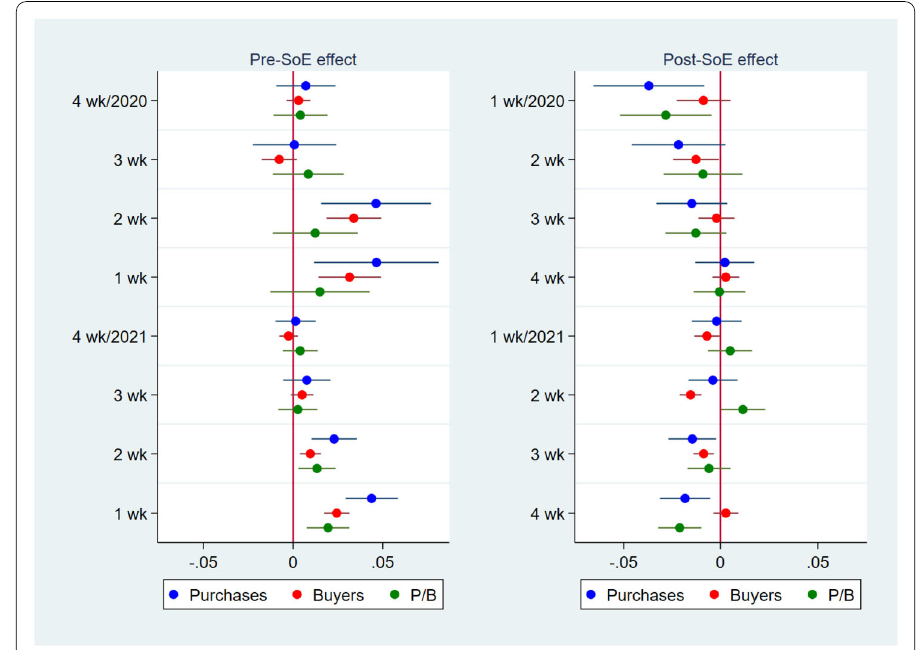
Figure 6 Pre- and Posttreatment Effects of the Declaration of a State of Emergency on the Purchase Amount, the Number of Buyers, and the Purchase Amount per Buyer. This figure illustrates the results from the regressions of the purchase amount, the number of buyers, and the purchase amount per buyer in logs at the city–date level. The left panel shows the point estimates and 95% confidence intervals of the dummies for 1-4 weeks before the declaration of a state of emergency (SoE) on the purchase amount (blue), the number of buyers (red), and the purchase amount per buyer (green). The right panel shows those of the dummies for 1-4 weeks after the end of an SoE. The dummies for before and after an SoE are given at the prefecture–date level. For example, “4 wk/2020” on the x-axis of the left panel means 4 weeks before an SoE in 2020, whereas “1wk/2020” in the right panel means 1 week after an SoE in 2020. In all the regressions, the other independent variables are the number of COVID-19 cases per 1000 persons; the dummies for an SoE; the number of neighboring prefectures in an SoE; and the city, date, and day-of-the-week fixed effects. The standard errors are clustered at the city level. N =